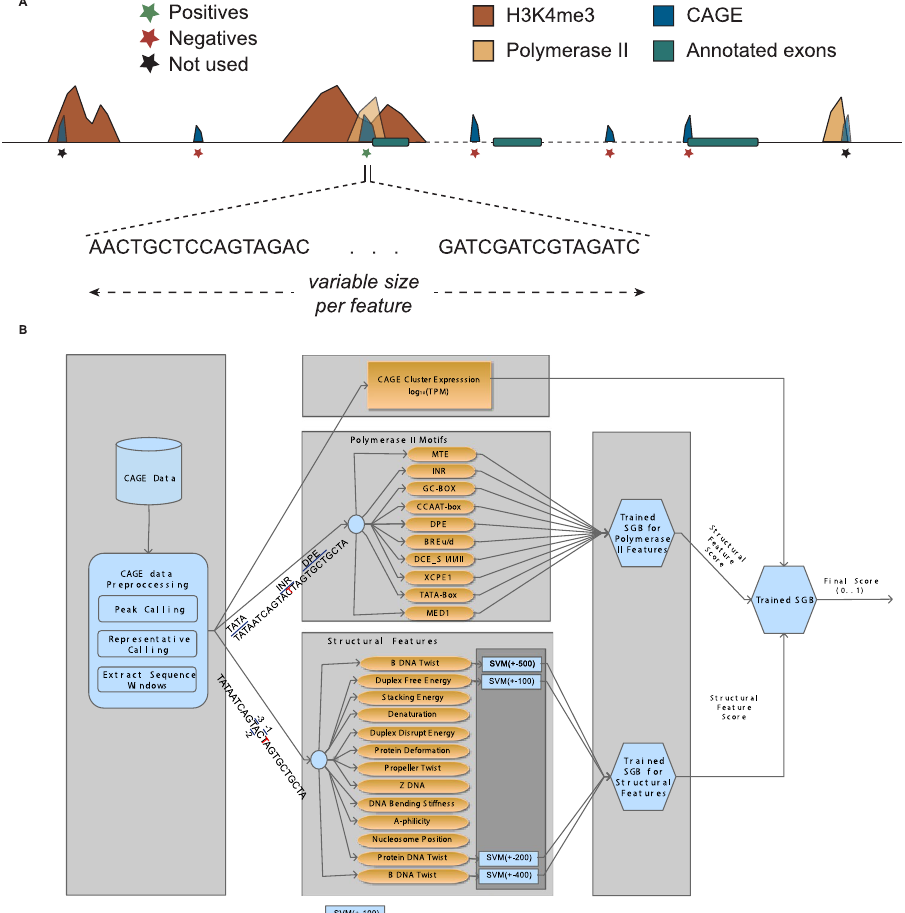
Figure 1. Overview of ADAPT-CAGE and the training process. ( A ) CAGE clusters selected for the positive set originated from annotated promoter regions with H3K4me3 and Polymerase II ChIP-Seq occupancy. Negative samples were selected from intronic, exonic and intergenic regions that did not overlap H3K4me3 or Polymerase II peaks. ( Β ) ADAPT-CAGE accepts as input aligned reads in BAM format. The preprocessing module aggregates CAGE reads into peaks and finds their representative nucleotide (the position exhibiting the highest expression within each peak). The sequence surrounding the representatives is extracted and the structural as well as Polymerase II features are calculated and forwarded on their own GBM (Polymerase II motifs) and SVM (structural features) models. The last module of the framework is based on a GBM model that combines previous outputs with the expression level of candidate TSSs to produce the final output of the